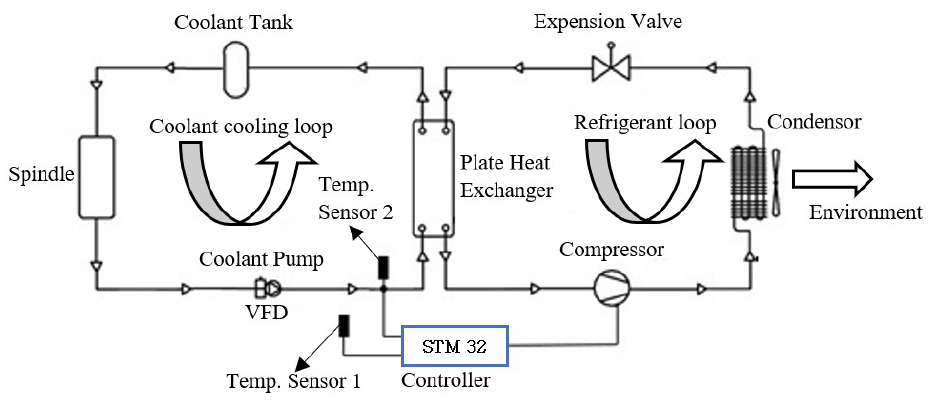
Figure 3. Working of the cooling control